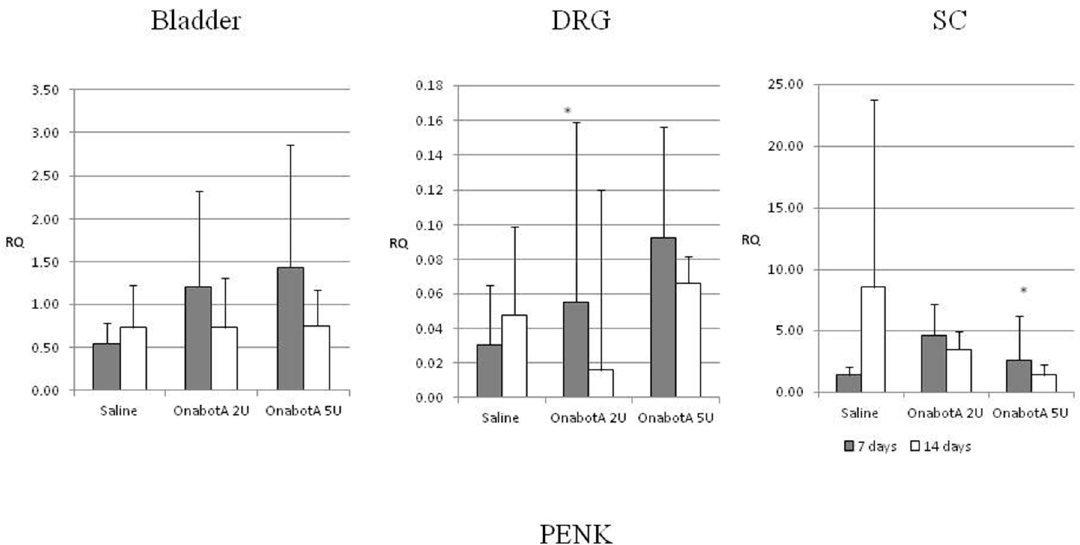
Figure 4. Relative expression of PENK in the bladder, DRG (dorsal root ganglia) and SC (spinal cord) of saline-treated (7 days post-treatment, n = 5; and 14 days post-treatment, n = 5) and OnabotulinumtoxinA-treated rats (7 days post-treatment, n = 5; and 14 days post-treatment, n = 5). Expression was normalized to that of GAPDH. RQ: relative quantification. Error bar: standard deviation. *: statistically significant difference ( p < 0.05) with respect to saline. All statistically significant p -values are presented in Table 1.